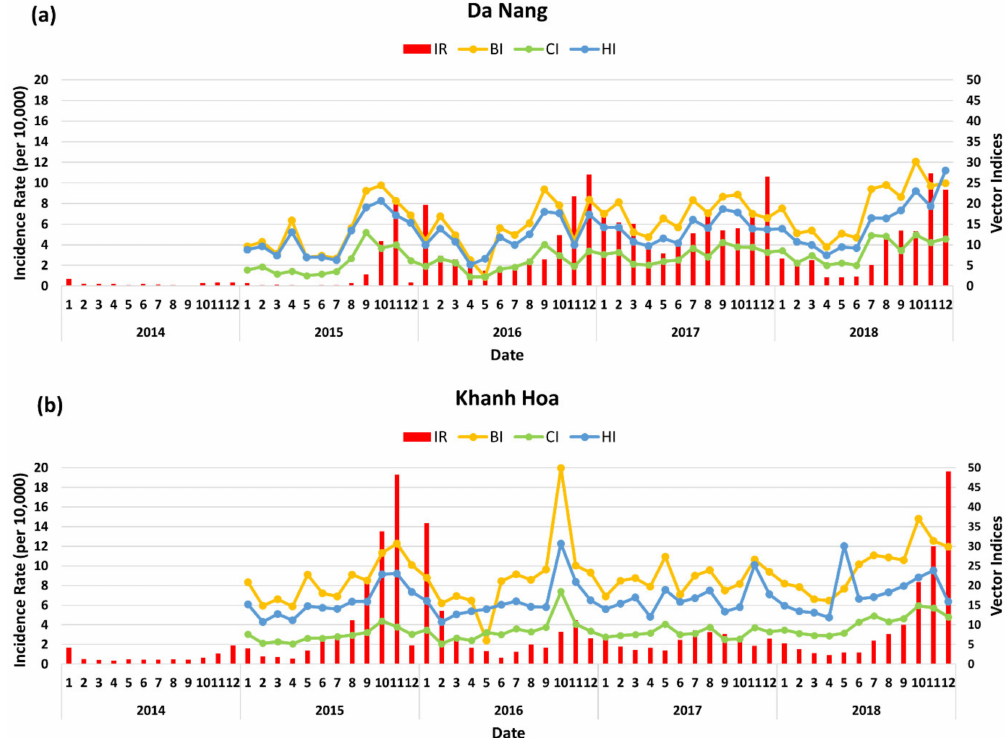
Figure 4. Monthly dengue incidence rate (per 10,000) and vector indices in Da Nang ( a ) and Khanh Hoa ( b ) between 2014 and 2018 ( density index (DI) and house infestation index (HIF) were excluded because DI had a very low value during the study period and HIF did not correlate with dengue transmission in the study areas) . IR—incidence rate; BI—Breteau index; CI—container index; HI—house index.